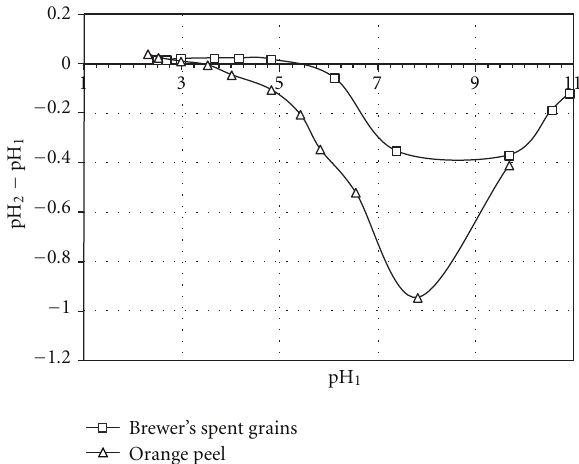
Figure 2: Zero charge point of agroindustrial